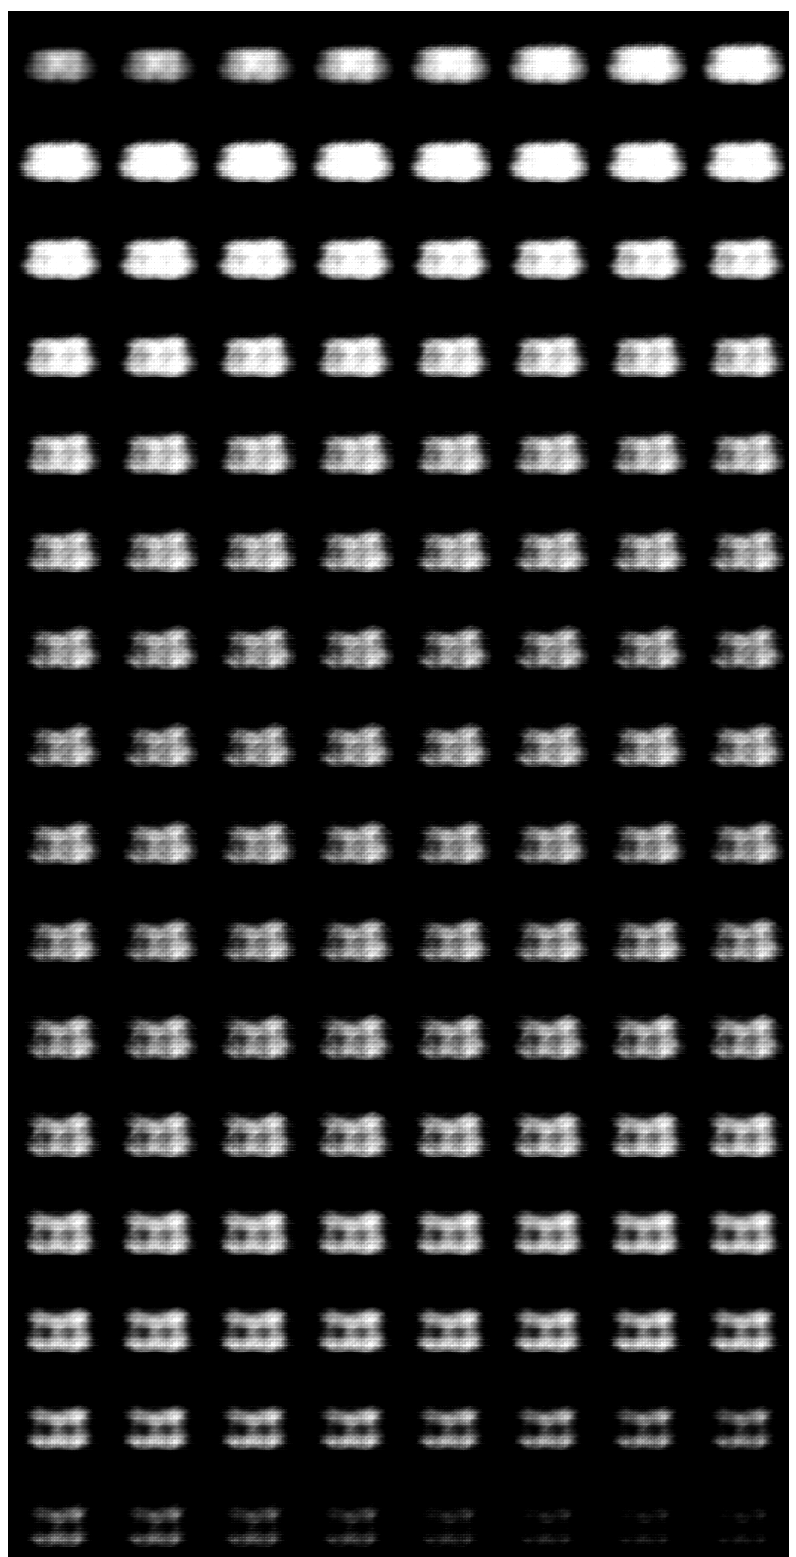
Figure A1. Fictional mean 3D CT image at 48 epochs (sampled with T = 0, standard learning), in pulmonary window